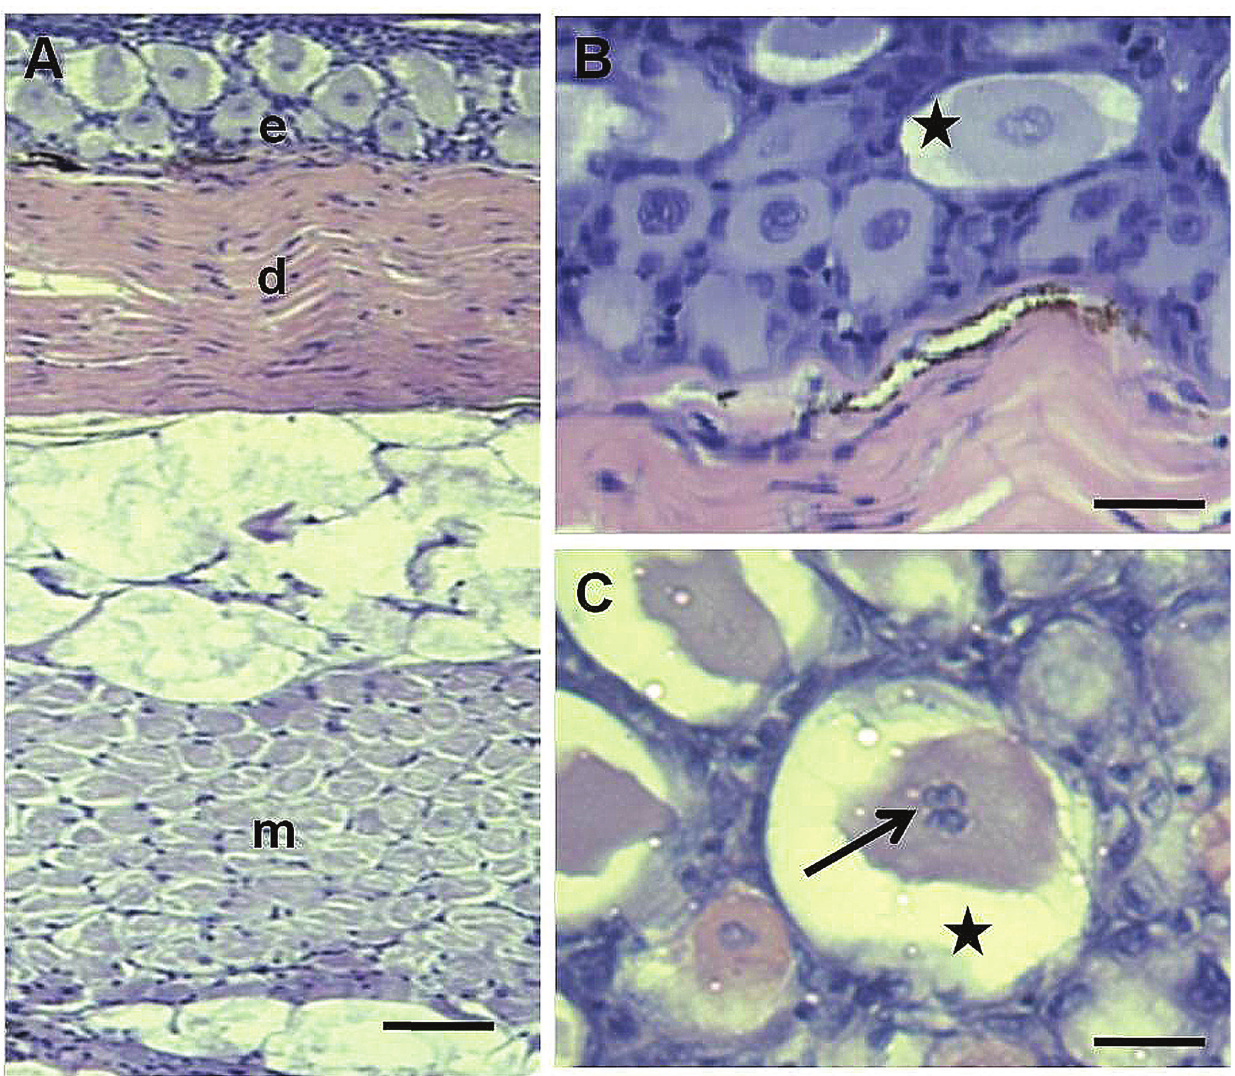
Fig. 2. Epidermis of R. quelen under light microscopy, PAS and hematoxylin staining. (A) Broad view showing the different skin layers: epidermis (e), dermis (d), and skeletal muscle (m). Scale bar = 5 µm; (B) club cells within the epidermis (star). Scale bar = 3 µm; (C) larger magnification of a club cell, with the arrow indicating the presence of the two nuclei. Scale bar = 1